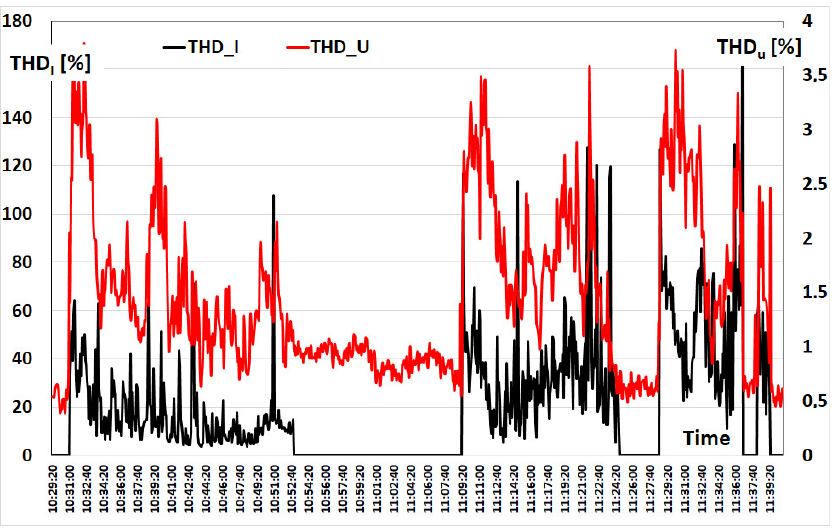
Figure 2. Changes in THD I and THD U coefficients in the different smelting phases in the electric arc furnace.